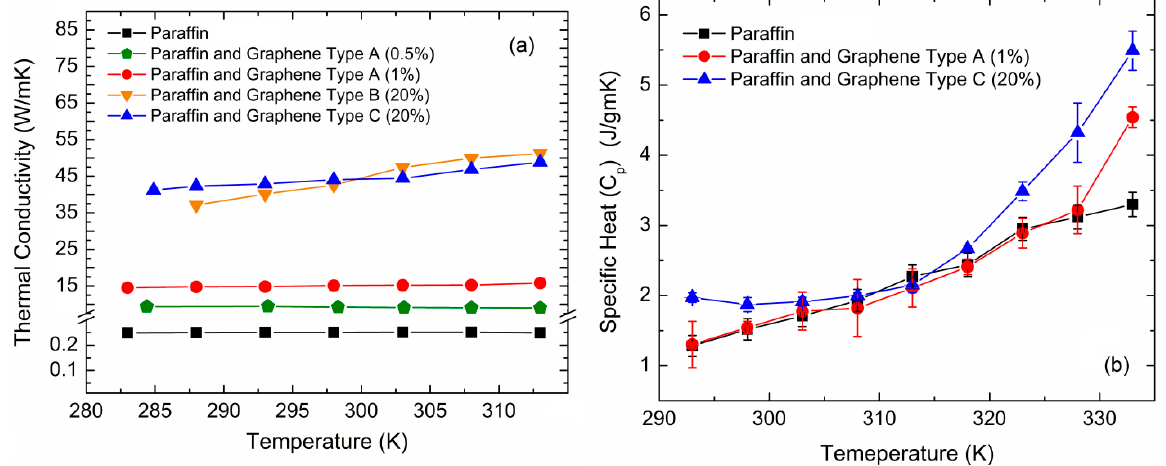
Figure 4. Thermal properties of hybrid graphene-PCM. ( a ) Enhancement factor of thermal conductivity of the graphene—paraffin composites with different graphene loading as a function of temperature. The results for pristine paraffin are also shown for comparison; ( b ) Specific heat of the composites and reference pristine paraffin as a function of temperature. The image is reprinted with permission from [29]. Copyright 2014